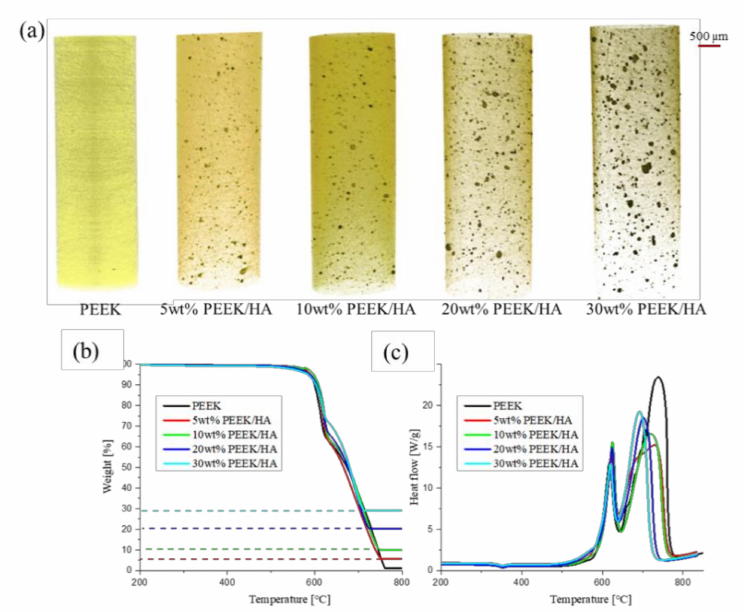
Figure 1. ( a ) CT Scans of produced filaments, ( b ) Thermogravimetry for the PEEK/HA compos- ite filaments and pure PEEK with a heating rate 20 ◦ C/min; weight% versus temperature and ( c ) Thermogravimetry heat flow versus temperature for the PEEK/HA composite filaments and pure